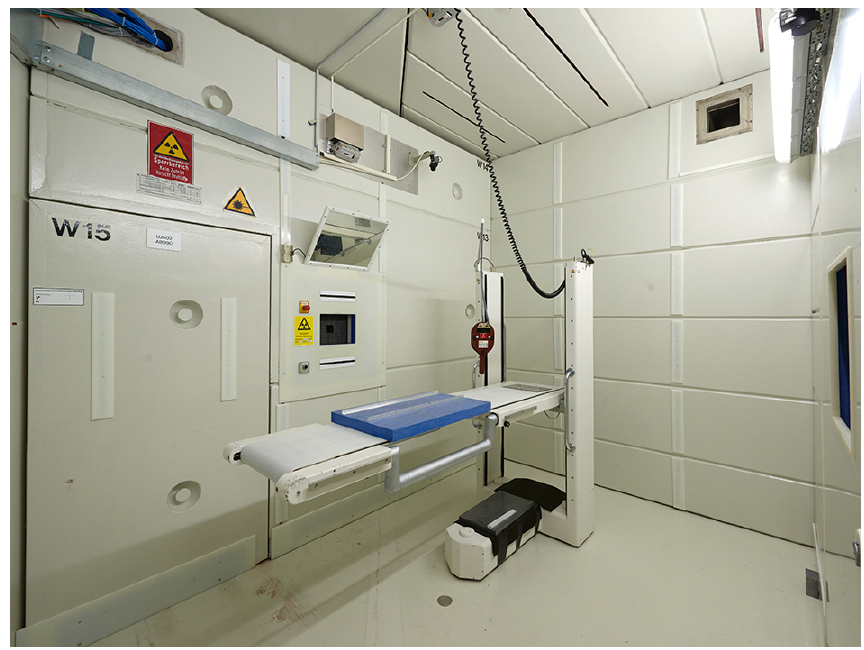
Figure 1: The irradiation room of MEDAPP (Copyright by W. Schürmann, TUM).